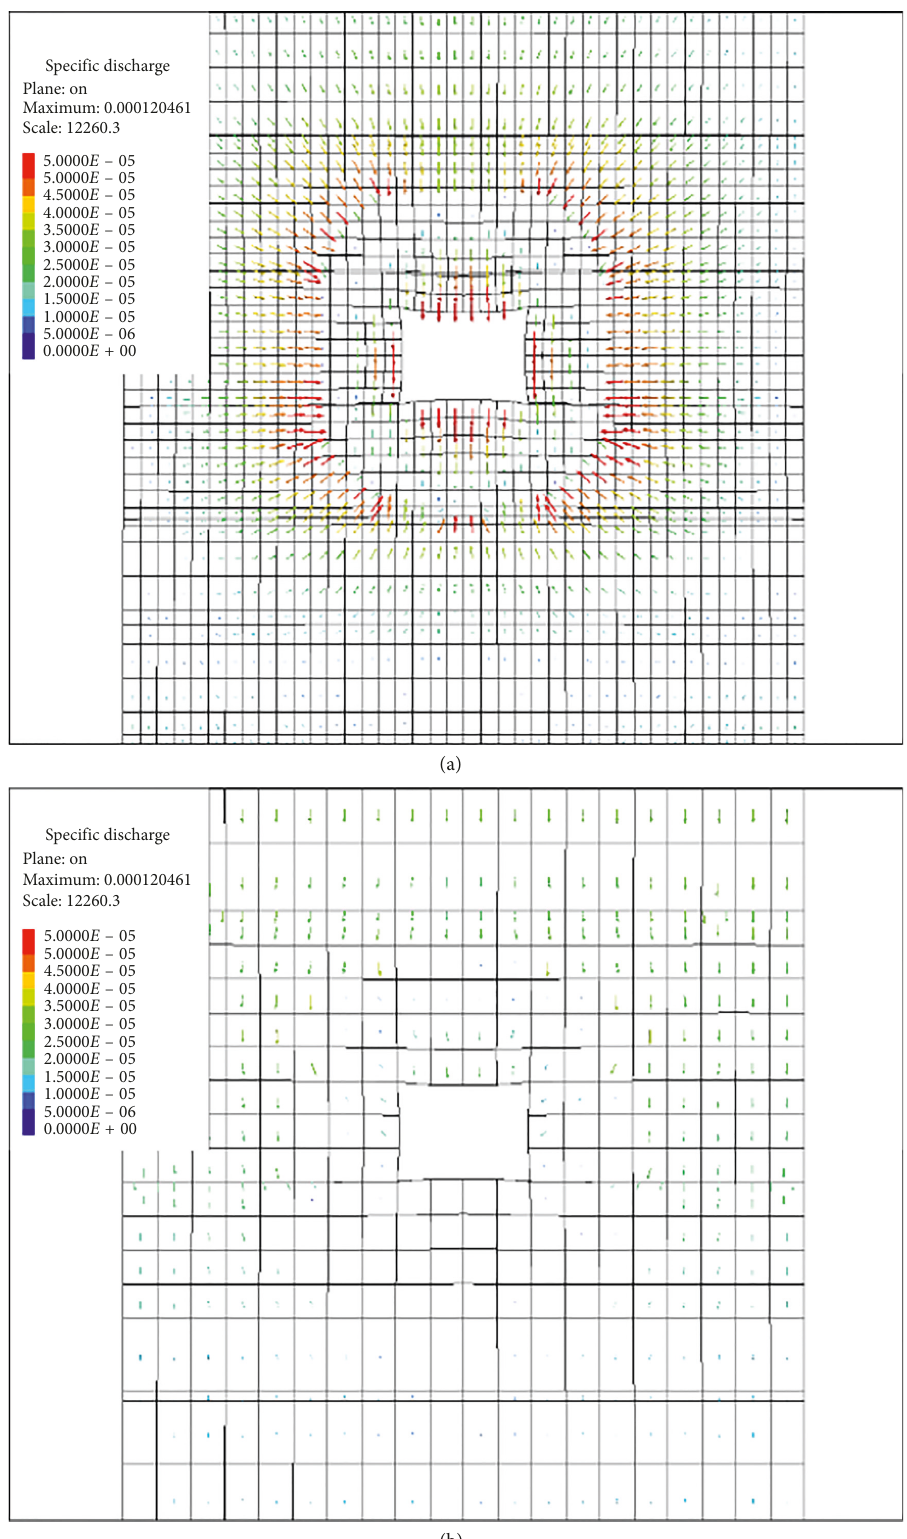
Figure 7: Flow velocity of fractured water in the fault fracture zone under different supporting conditions. (a) Shed supporting condition and (b) bolt-grouting supporting